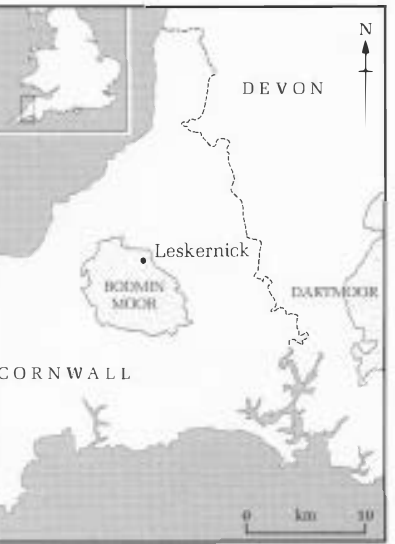
Figure 2 Southwest England showing the location of the granitic massifs